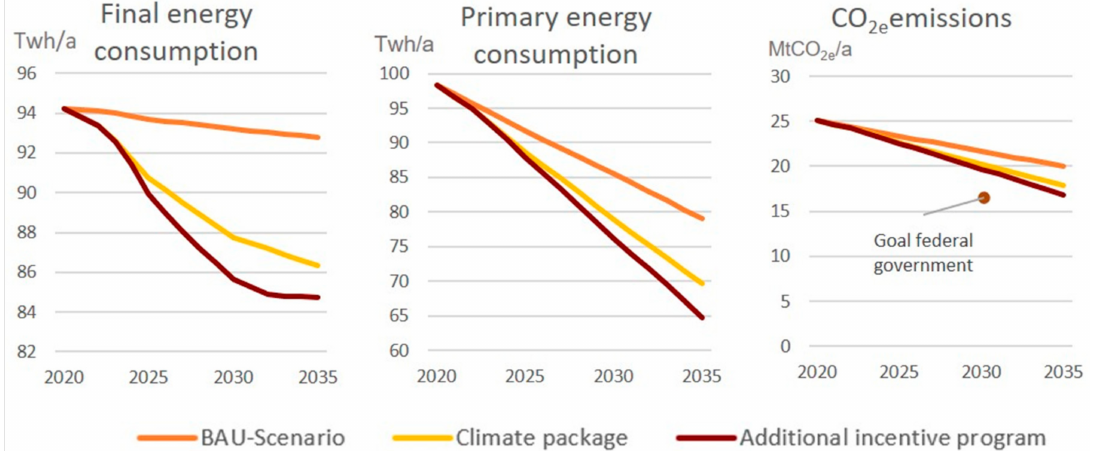
Figure 6. Primary energy consumption, final energy consumption and CO 2e -Emissions in the scenarios over the simu- lated